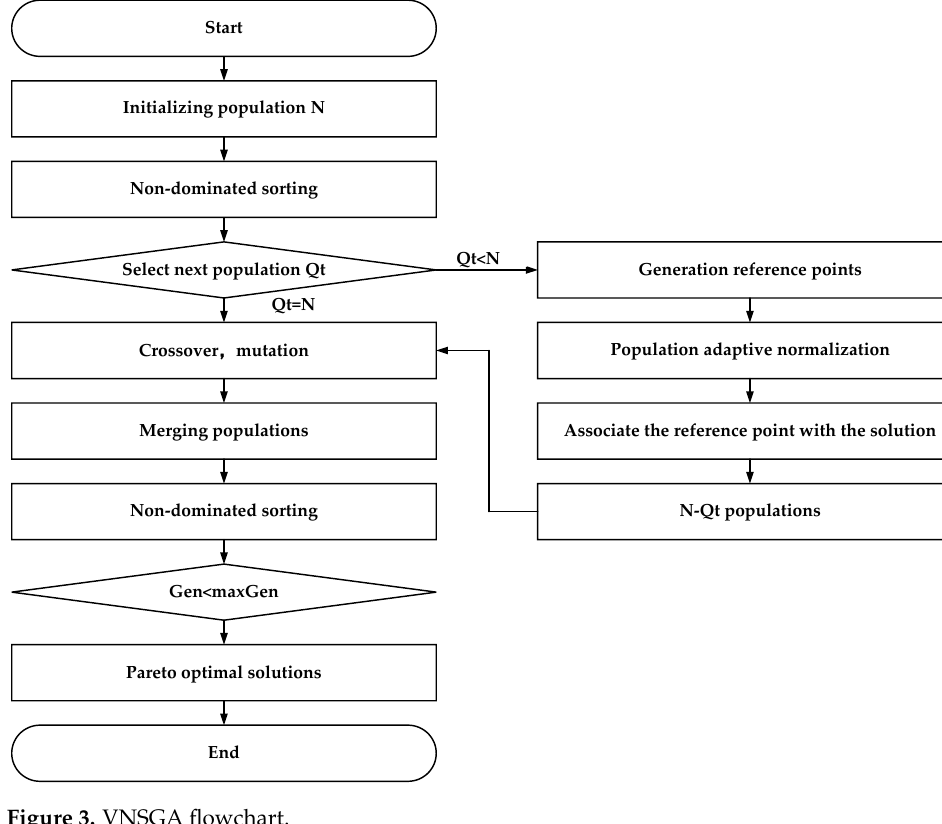
Figure 3. VNSGA flowchart.